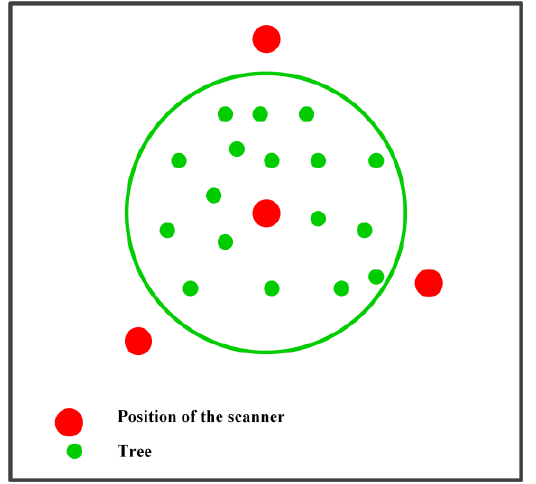
Figure 4. Multiple scan mode (Bienert et al., 2006)